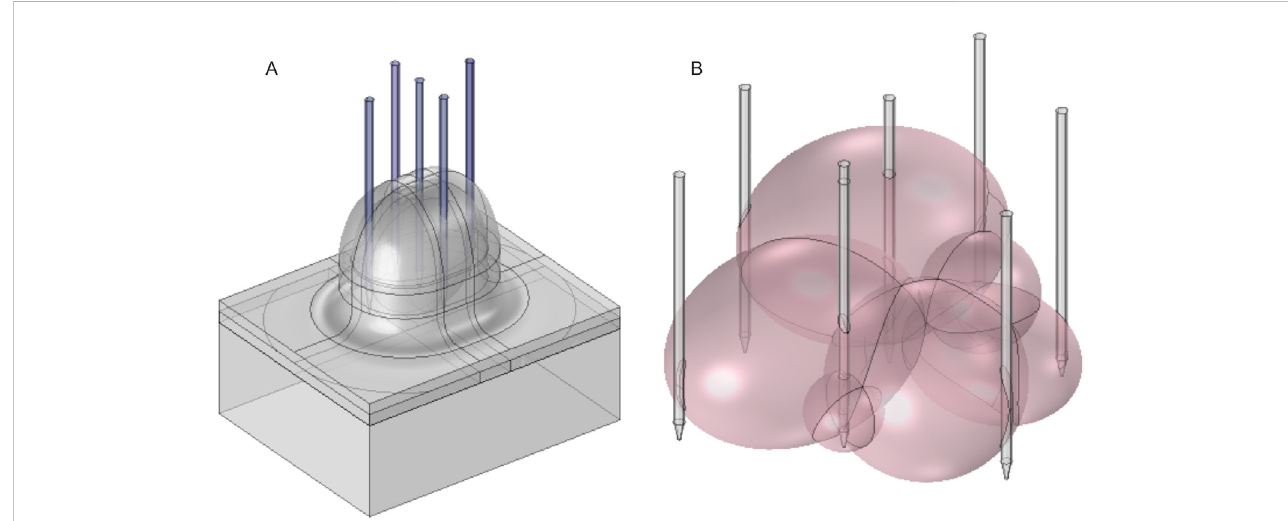
Array of adjustable needle electrodes for (A) corneous tumors and (B) deep-seated tumors.